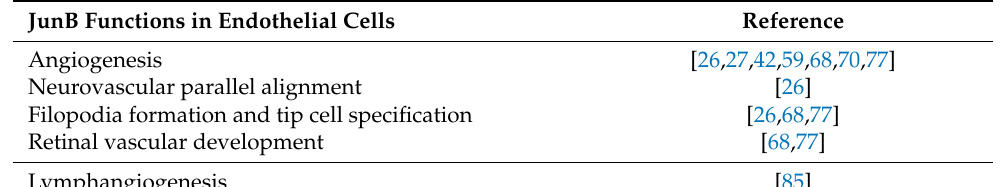
Table 1. Original articles which describe JunB functions in angiogenesis and vascular